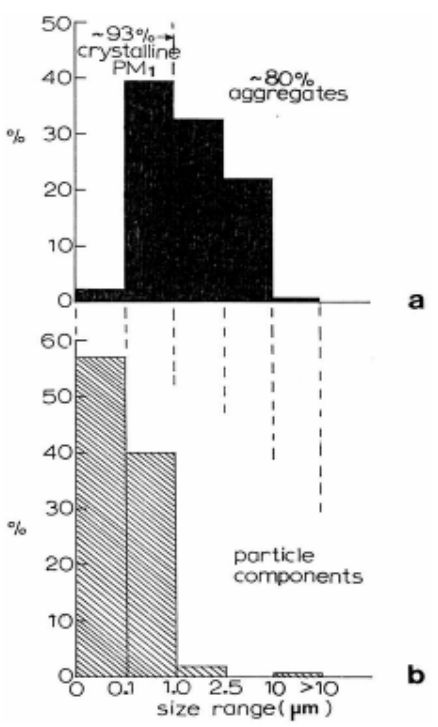
Figure 1 : (a) PM (average) size (dp) range versus PM abundance as a percent of the total PM analyzed. Note that 93% of PM, were crystalline while 80% of all PM were aggregates. (b) Primary particle component sizes (size ranges) versus percent of the aggregated PM in (a). Note that >95% of all primary particles were PM . PM collected in the El Paso, TX, USA were PM 0.1 outdoor air.